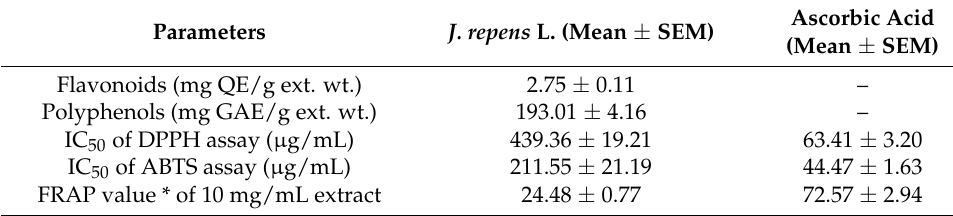
Ascorbic Acid (Mean ± SEM)